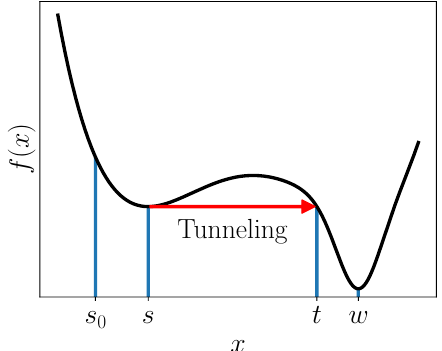
Figure 1. Visualisation of the tunneling approach for minimisation as used in AMPGO [132]. From the initial sample s the local optimum at s is found. After it is found, Tabu Tunneling is 0 used to find location t , from which the local gradient-based approach can be reused again to find the global minimum at w